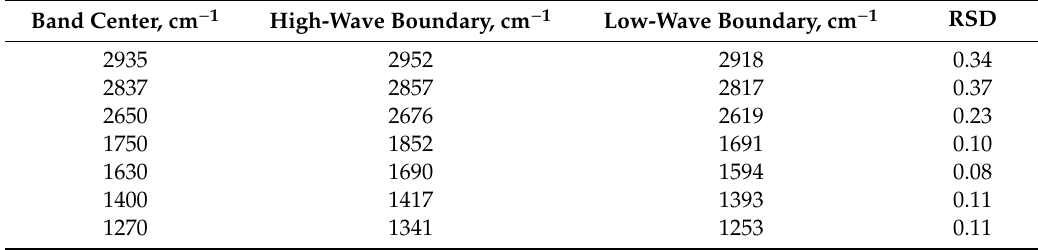
Relative standard deviation of band integral intensities in the wavenumber range 3000–2000 cm − 1 by DRIFT (RDDM ND